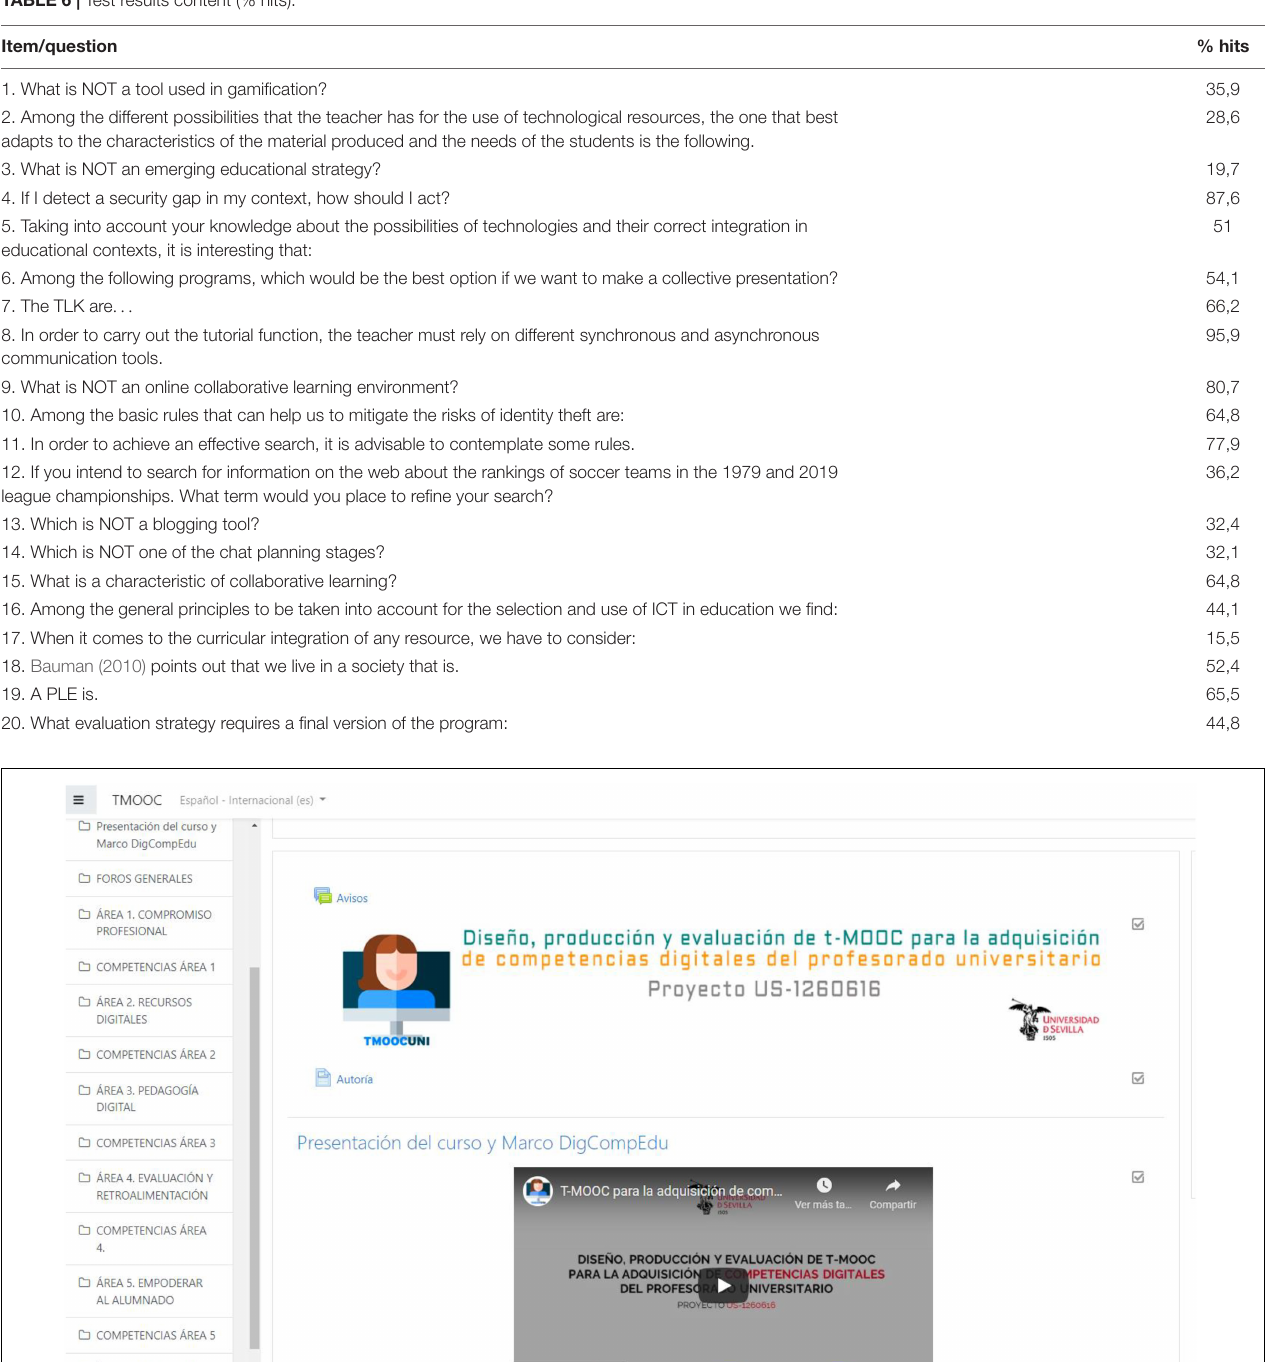
the University of Seville. For this purpose, the platform chosen for the design and development of the t-MOOC